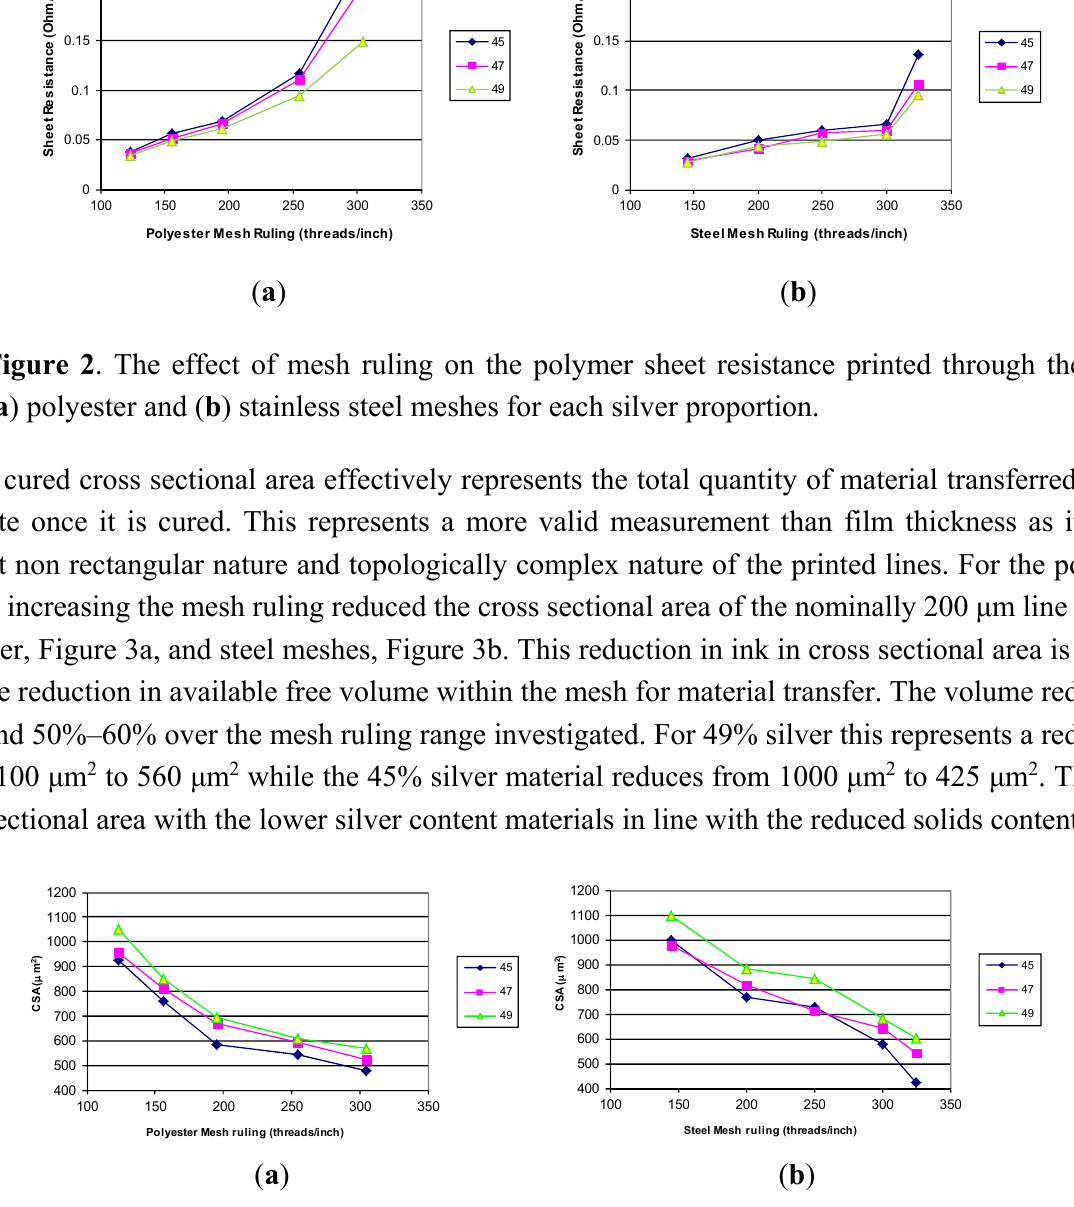
Figure 3. The effect of mesh ruling on the cured cross sectional area of the polymers inks for a nominally 200 μ m line ( a ) polyester and ( b ) stainless steel meshes for each silver